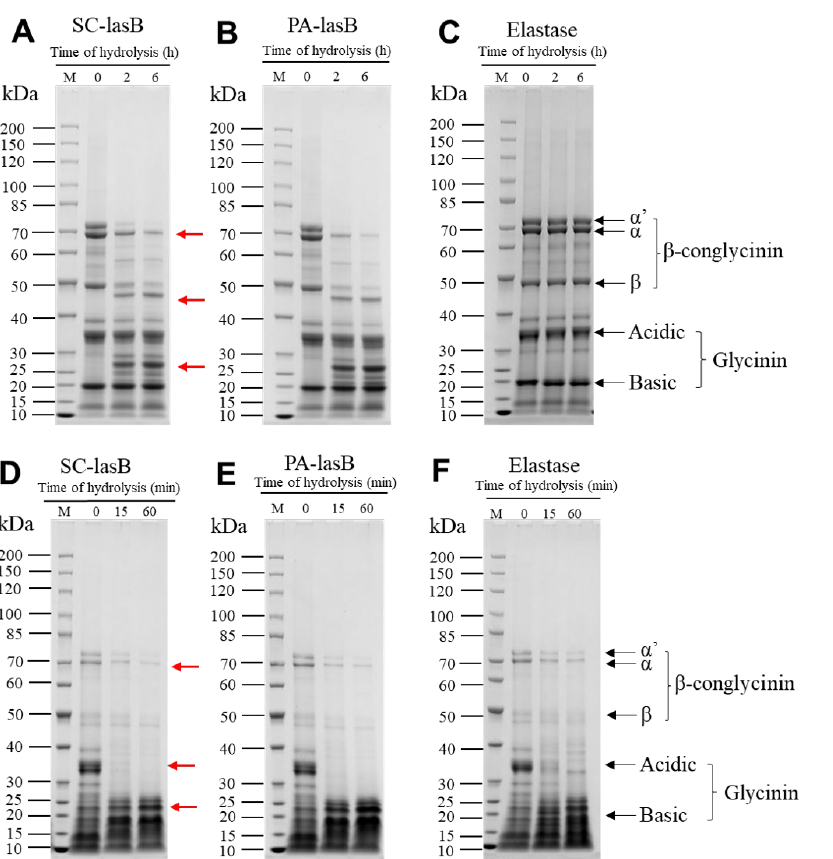
Figure 6. SDS–PAGE patterns of soy protein isolate hydrolysis obtained by SC-lasB and PA-lasB treatment (60 °C, pH = 7.0) with elastase from the porcine pancreas (50 °C, pH = 8.0) as the control group. ( A – C ) refer to the proteolysis of low-denatured soy protein isolate (LD-SPI). ( D – F ) refer to the proteolysis of high-denatured soy protein isolate (HD-SPI). Lane M: Protein Ladder (P0063, Beyotime). Red arrows represent protein bands that were degraded or newly